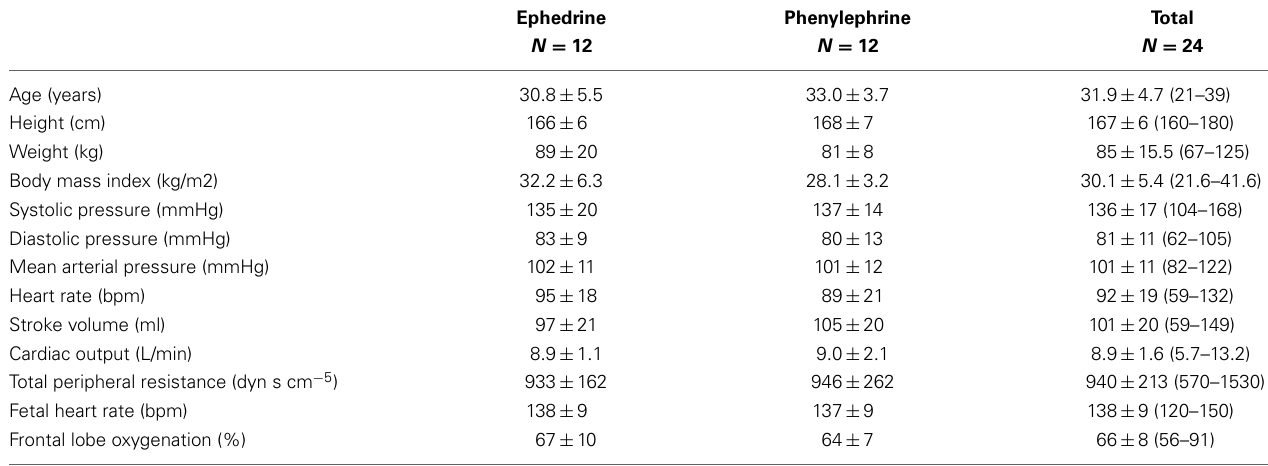
Table 1 | Patient characteristics, cardiovascular values, fetal heart rate, and frontal lobe oxygenation at baseline.